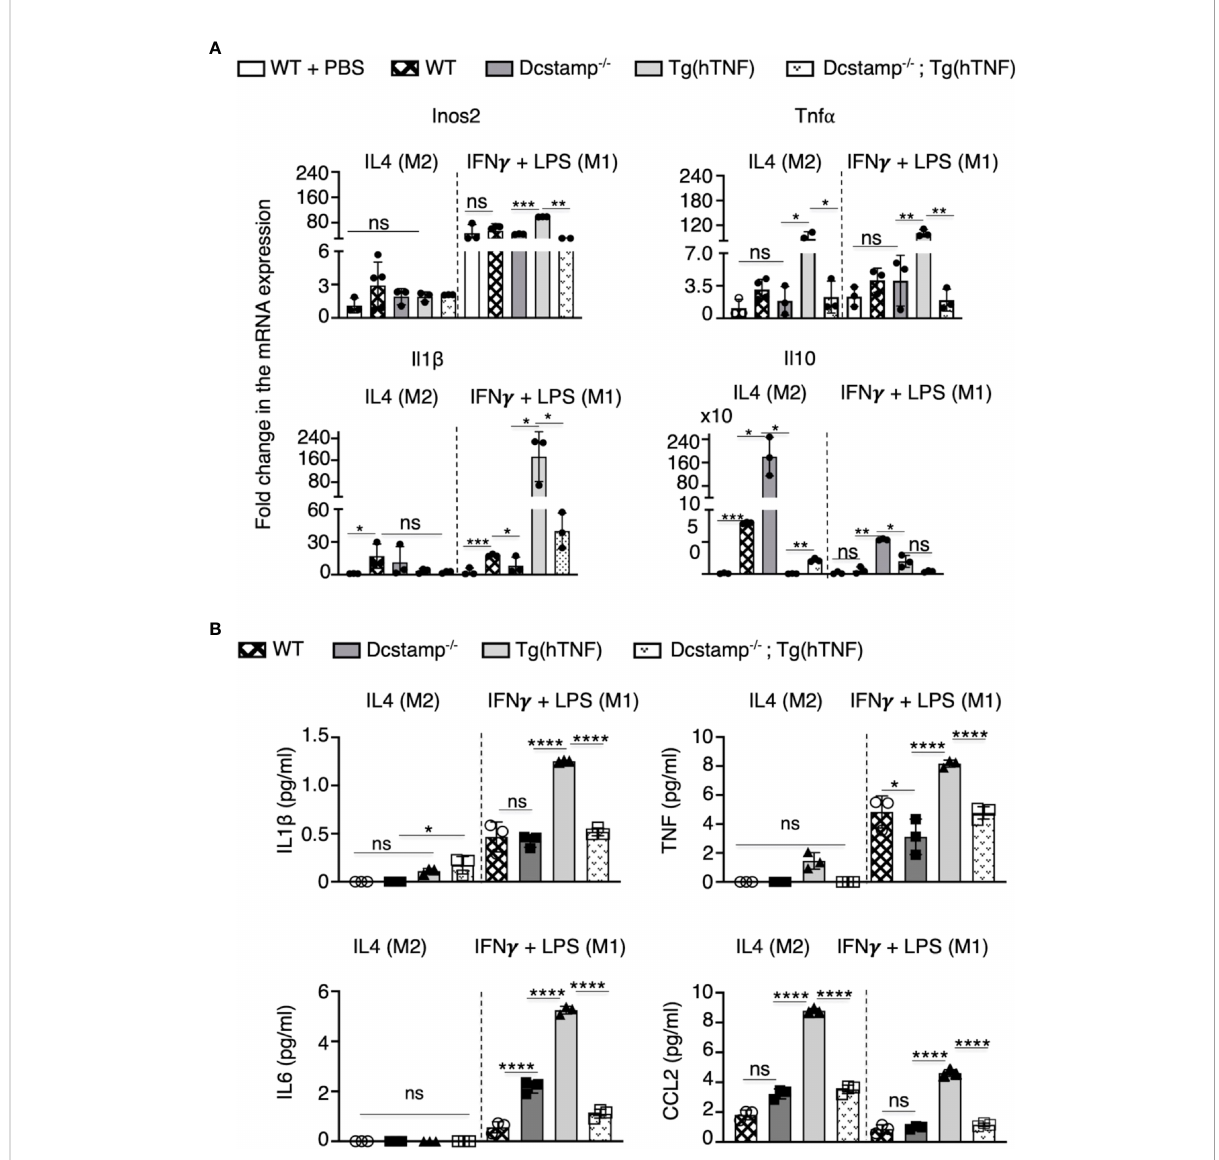
FIGURE 6 Absence of DC-STAMP decreased the expression of pro-in fl ammatory and antiin fl ammatory cytokines in macrophages from Tg(hTNF) mice. (A) mRNA expression for Nos2, Tnf, Il-16 and 1l-10 was estimated by RT-PCR in WT, Dcstamp -/- , Tg(hTNF) and Dcstamp -/- ;Tg(hTNF) CD11b+ adherent macrophages stimulated with the M2 polarizing cytokine IL-4 or the M1 polarizing factors: IFNY + LPS. (B) Quanti fi cation of IL1B, TNF, IL6 and CCL2 in supernatants collected at 72 h from cultures of adherent macrophages. Graphs represent the mean ± SD (n = 3). ns, not statistically signi fi cant,* p < 0.05, ** p < 0.005, *** p < 0.001, **** p < 0.0001 (Two-way ANOVA and paired Student's